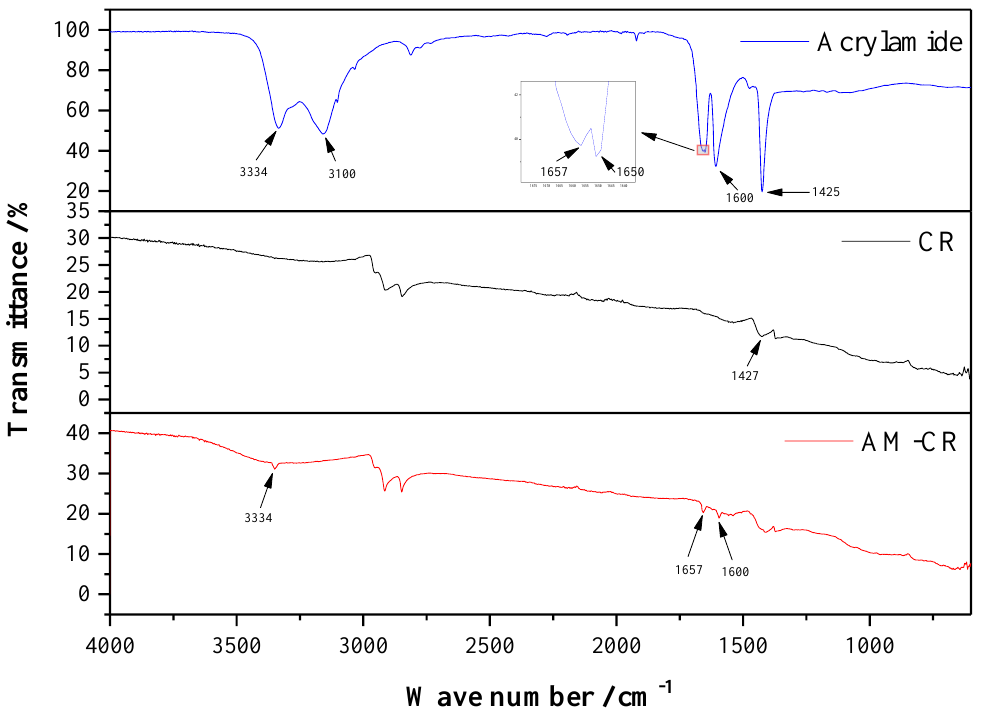
Figure 1. Infrared absorption spectrums of crumb rubber (CR) and activated crumb rubber (AM–CR). In the process of grafting, potassium persulfate acts as initiator and decomposes into sulfate ion − (SO 42 ) at high temperature to form a redox system. The allyl at the end of macromolecular chain of rubber has higher activity at high temperature, which makes the C = C bond on allyl easy to break and polymerize with the C = C bond of acrylamide to form long chains. The specific reaction process is as